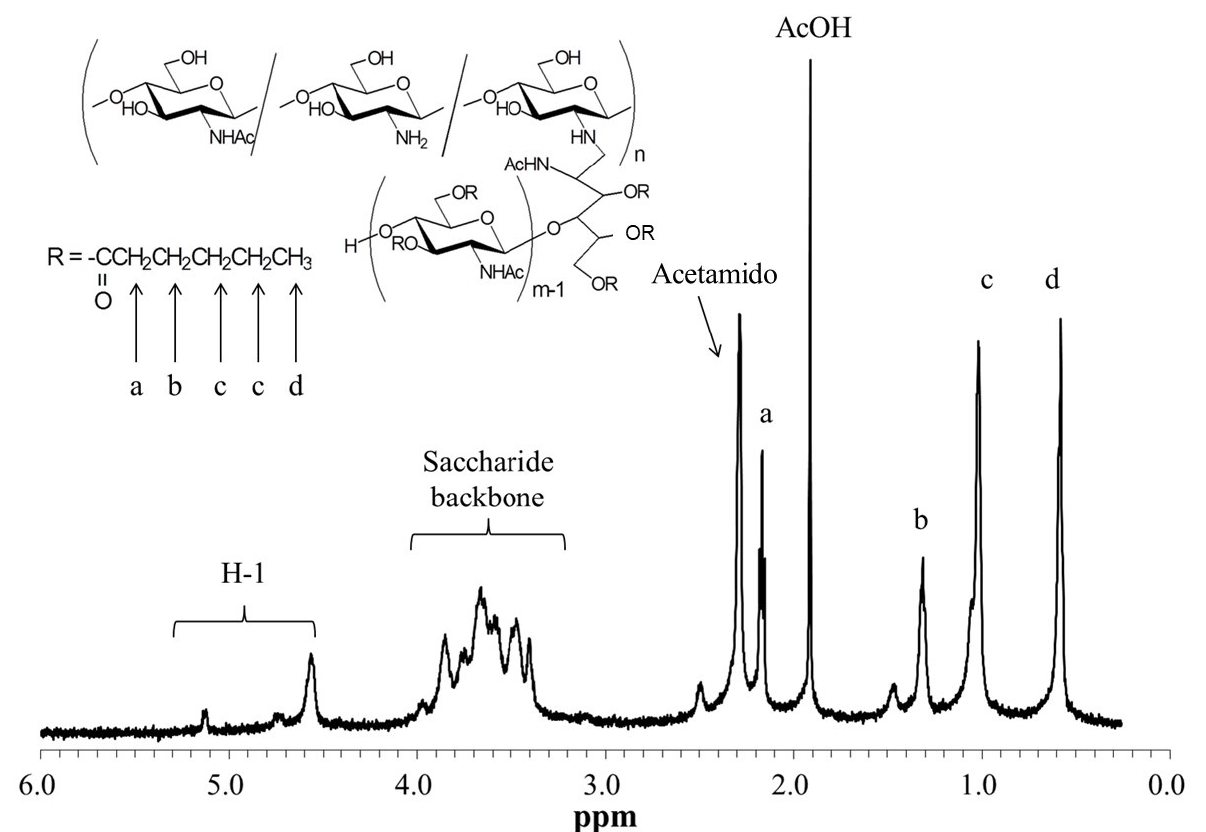
Figure 4. 1 H NMR spectrum of the sample after hydrolysis and dissolution of ChNFs with oligochitin dihexanoate graft chains in DCl/D 2 O.